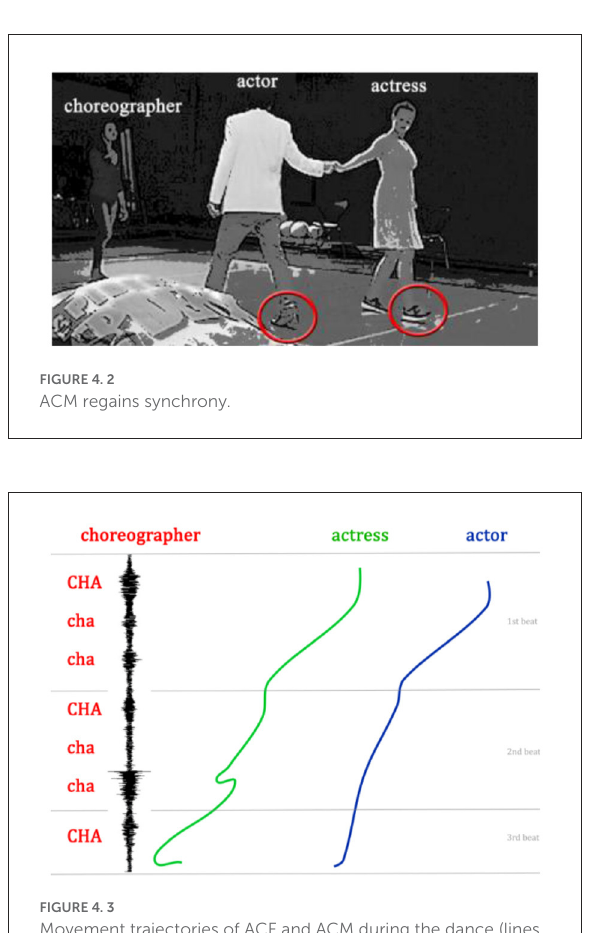
FIGURE4.3 Movement trajectories of ACF and ACM during the dance (lines 062–064).